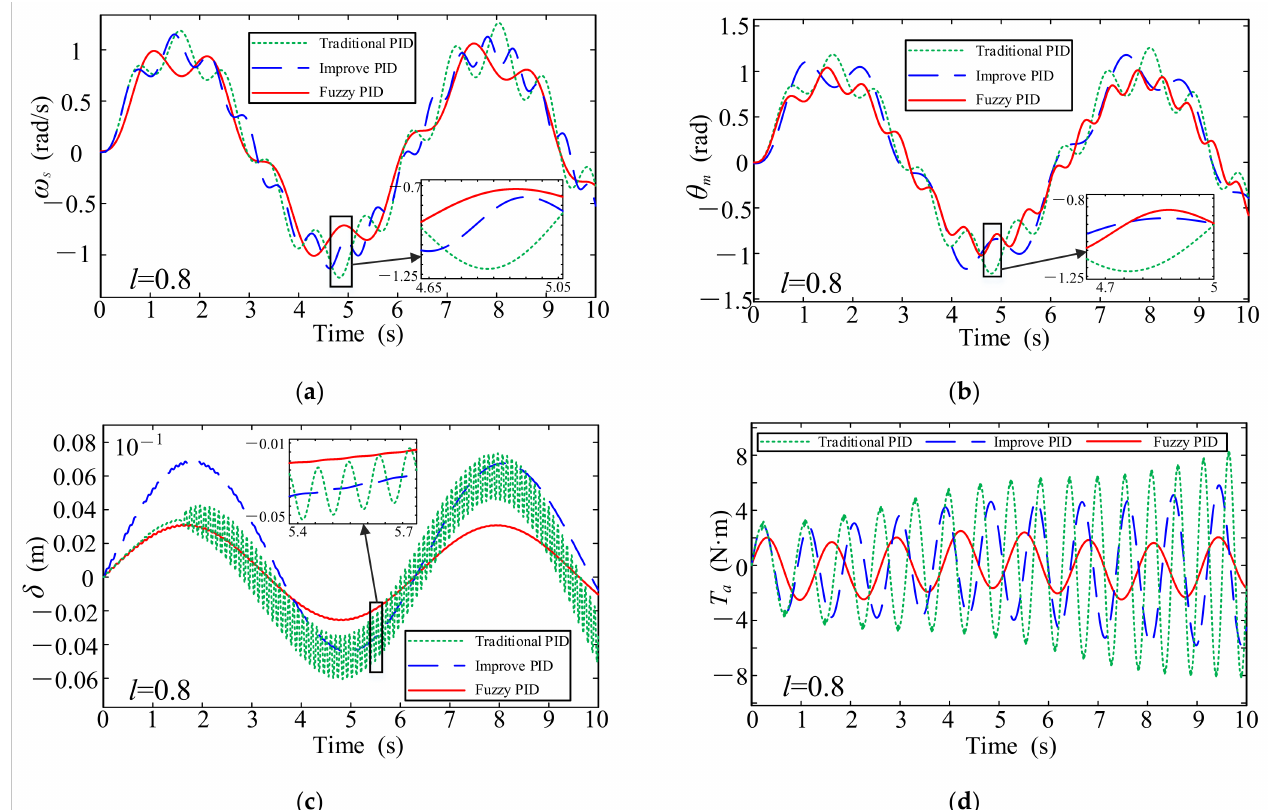
Figure 8. The output curve of the flexible load side in case 3: ( a ) the output speed; ( b ) the output angle; ( c ) output elastic deformation; ( d ) the output